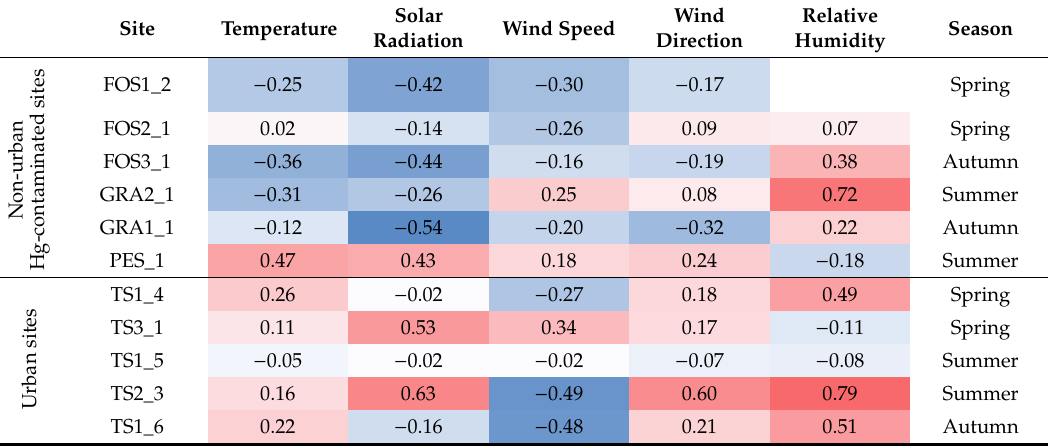
Table 2. Spearman (r) correlation matrix between GEM concentrations and micrometeorological parameters. Dark blue and red indicate strong negative and positive significant